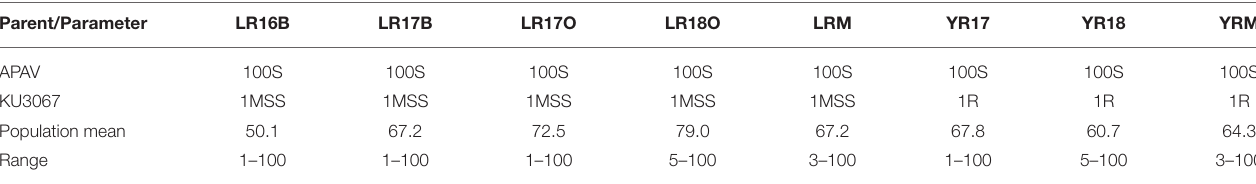
TABLE 2 | Summary of MDS in the KU3067 × Apav BIL population phenotyped for leaf rust and stripe rust.